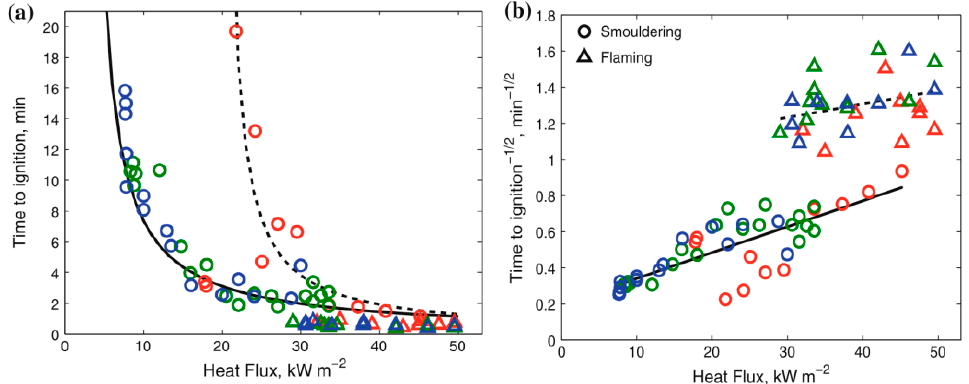
Figure 6. ( a ) asymptotic behavior of ignition time and ( b ) for smoldering and flaming samples [60]. Two different ignition patterns of PMMA plates were observed to occur more fre- quently in the recirculation zone and rarely at the end of the sample where the tempera- ture was high and the flow rate was low. The increasing of step height extended the igni- tion limit and shortened the ignition delay, making it more favorable for ignition